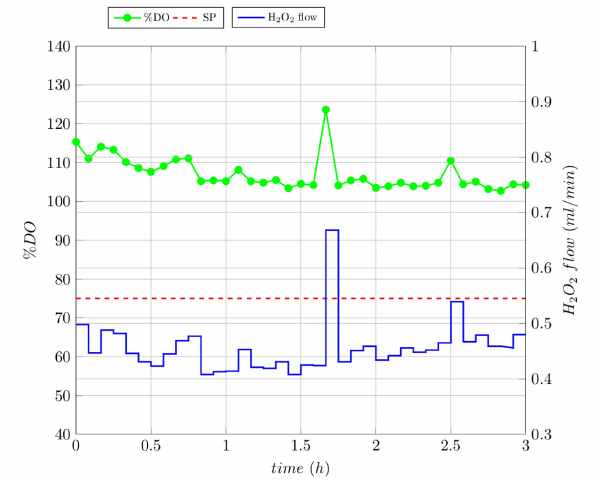
Figure 7. Degradation of melanoidin under Closed-Loop experiment